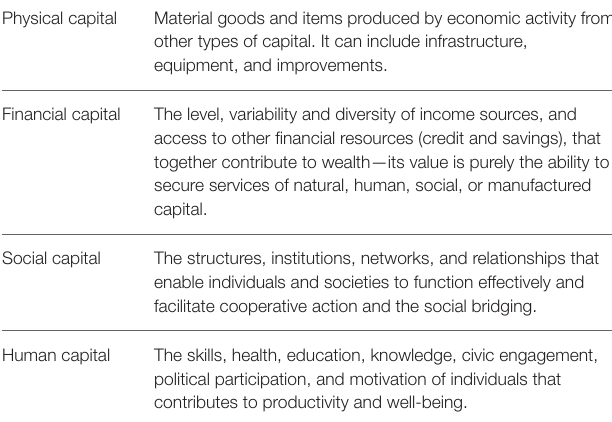
TABLE 1 | Definitions of the four capitals utilized in this study, adapted from Brown et al. (2010), Ellis (2000), and Tinch et al. (2015). Physical